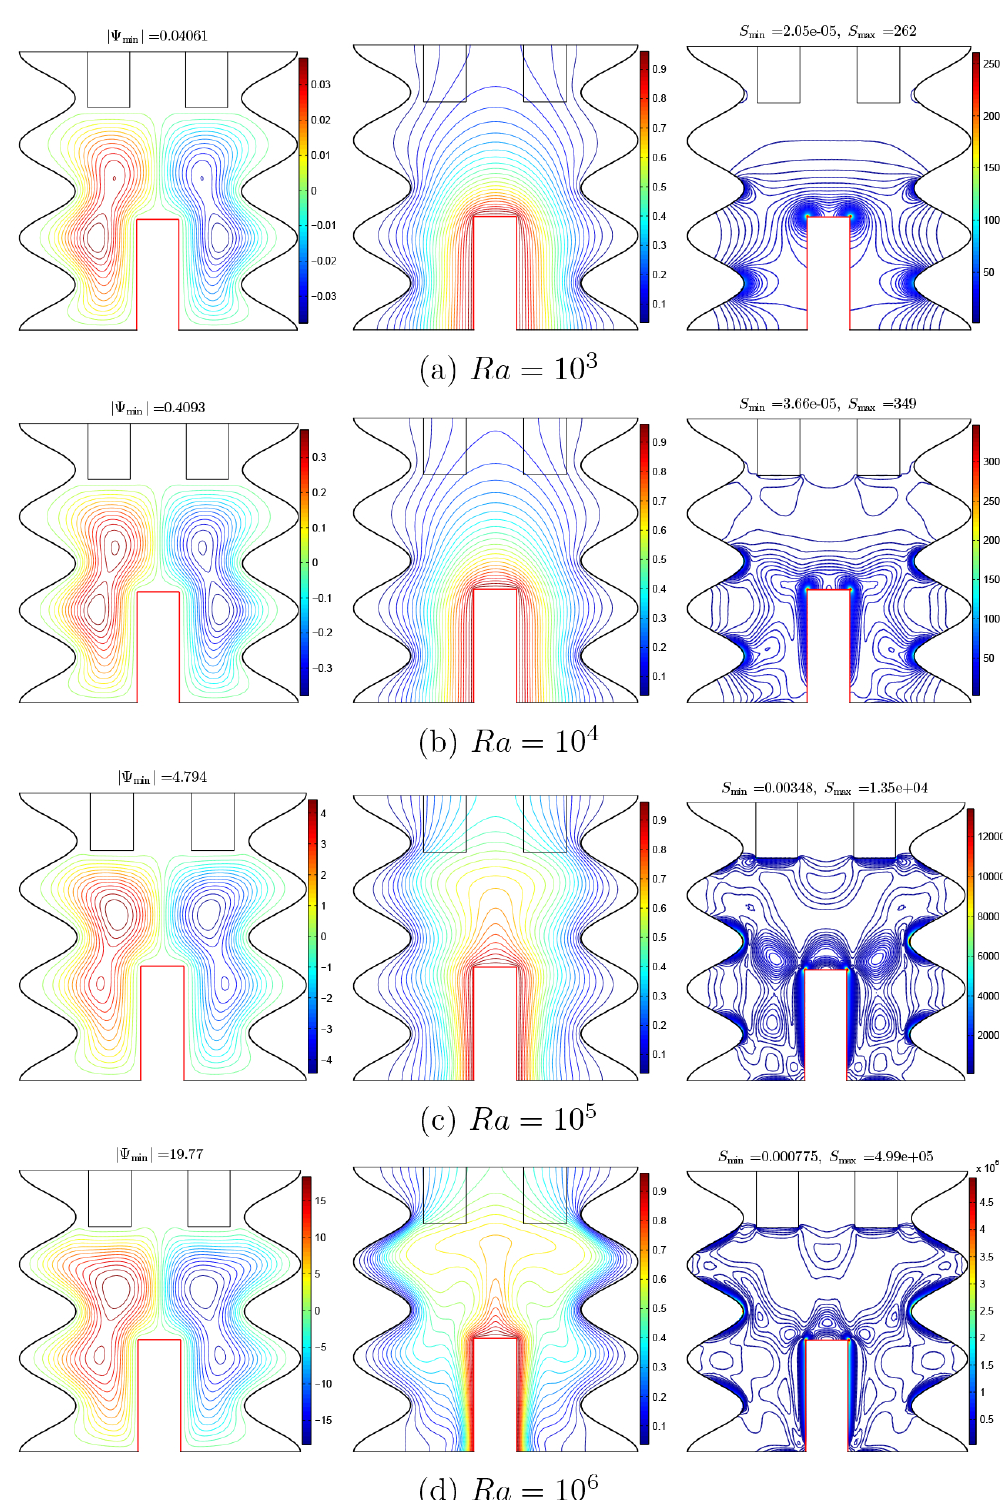
Figure 11. Evaluation of the streamlines ( left ), temperature contours ( middle ), and entropy generation patterns ( right ) for various Rayleigh numbers for hybrid nanofluids; φ = 0.02 and D =